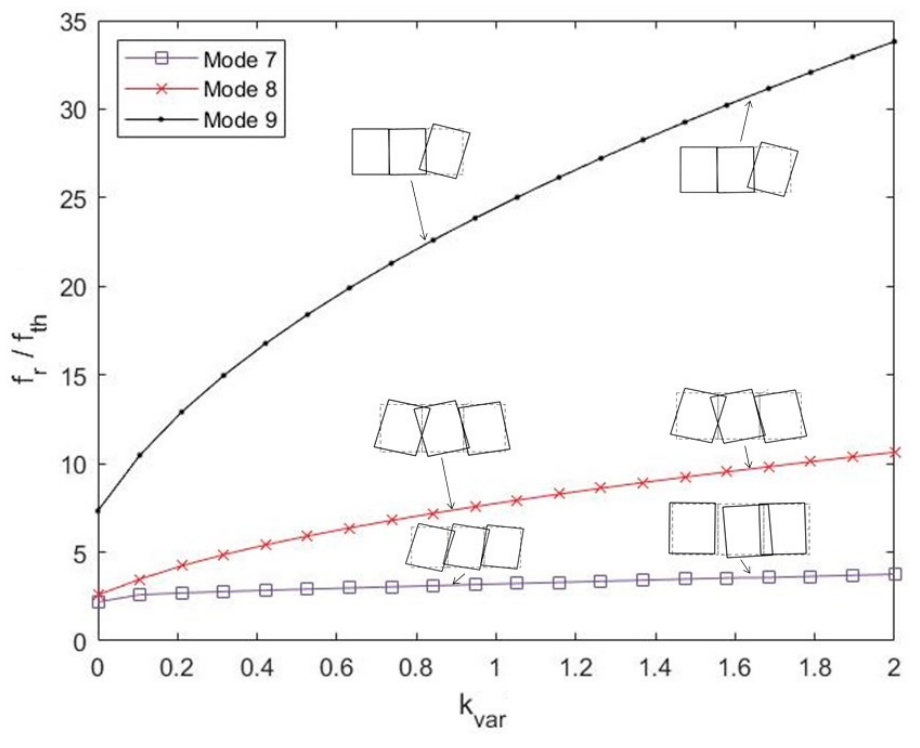
Figure 5. Variation of the modes and of the natural frequencies of the system from 7 to 9 as a function of k var .